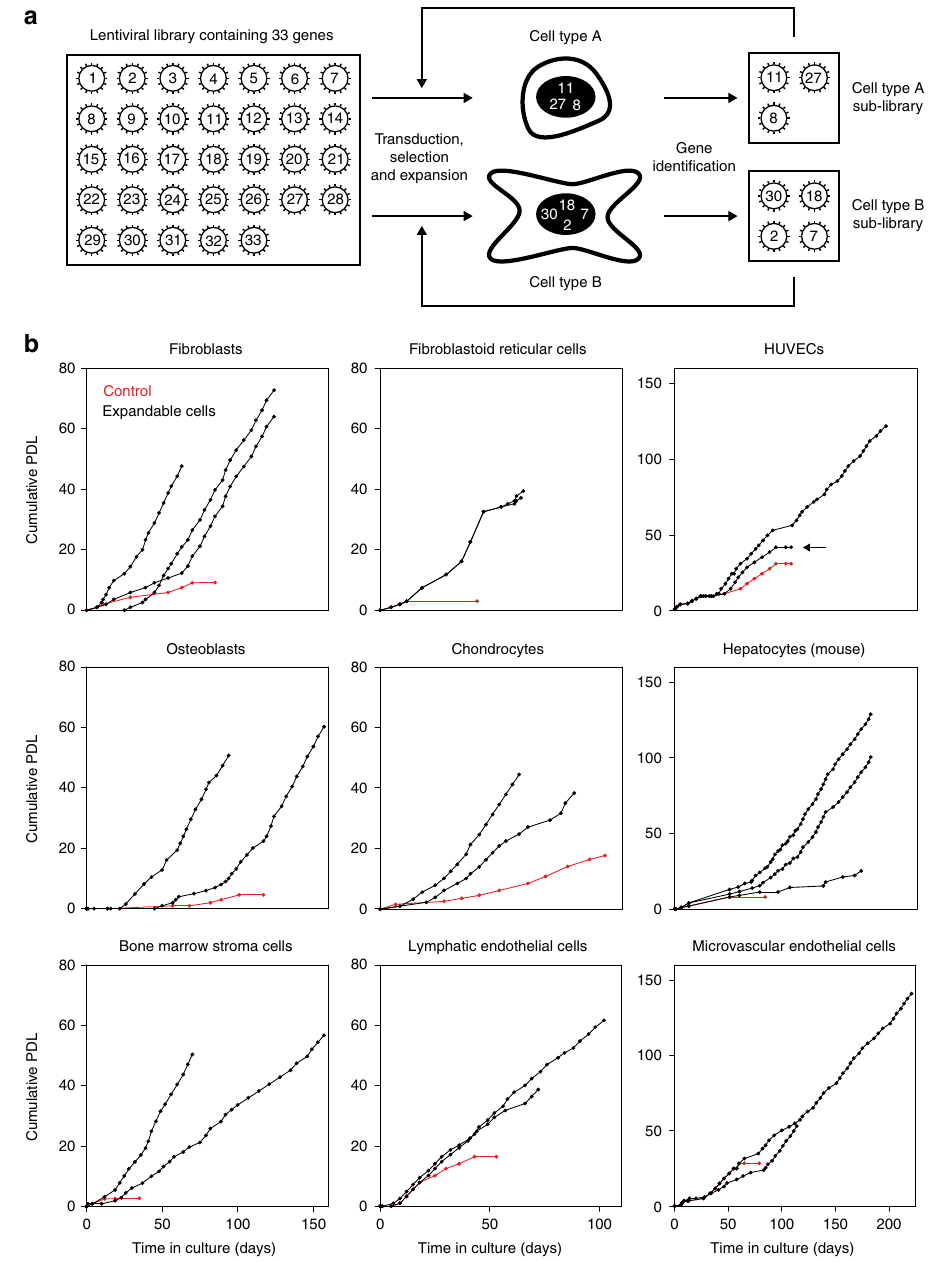
Fig. 1 Overall strategy and proliferation capacity of transduced cells. a Outline of the experimental strategy followed to establish cell lines. b Growth curves of various human and murine cell populations upon lentiviral transduction with the library of 33 genes (black lines), as well as of mock-infected primary cells (control, red lines). Cumulative population doubling levels (PDL) of the established cell lines as well as of respective primary cells are given for the indicated time period after infection (day 0). Transducing HUVECs with a single gene (MYC) resulted in limited expansion of the cells (marked by an